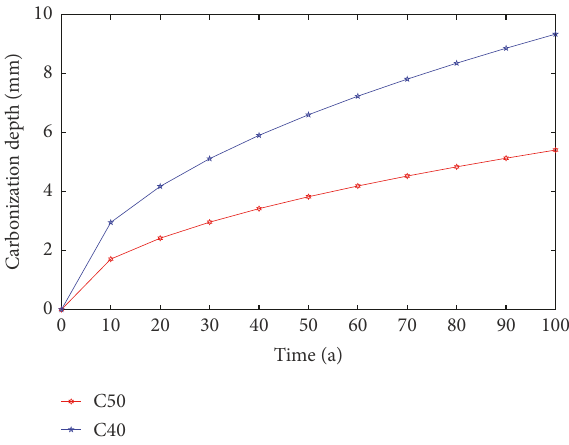
Figure 6: Mechanical property of C50 concrete.